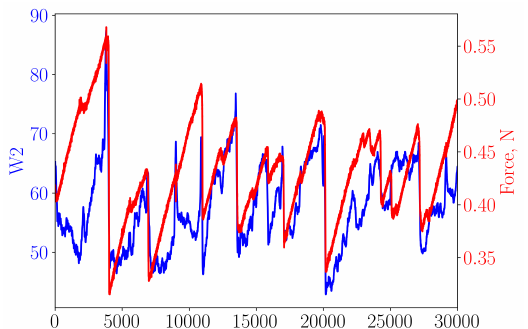
Figure 5: Force on the slider and W2 distance (data from Fig. 3a) and 4a)).